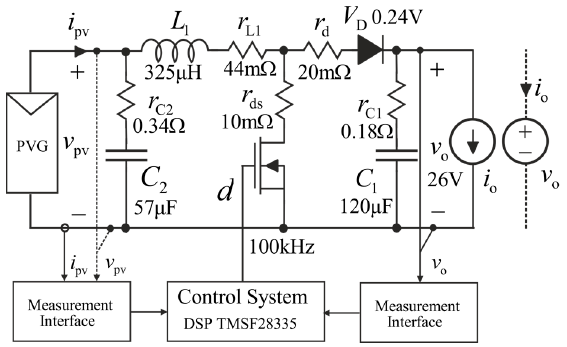
Figure 22. Boost-power-stage converter under output-voltage feedback control.